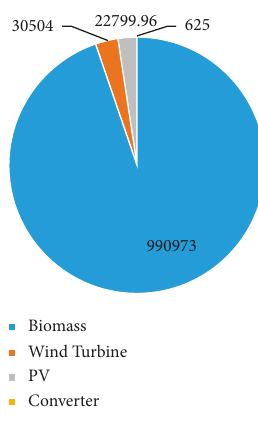
Figure 5: The cost summary of the Scenario 3.